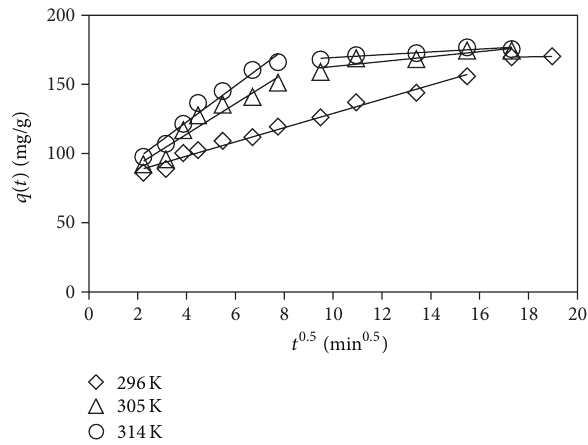
Figure 10: Effect of initial concentration on batch kinetics for sorption of glutaraldehyde on EDA-AC. 296 K; 0.8 g/L AC; pH 11.73 ± 0.03 ; − 425 + 300 𝜇 m.